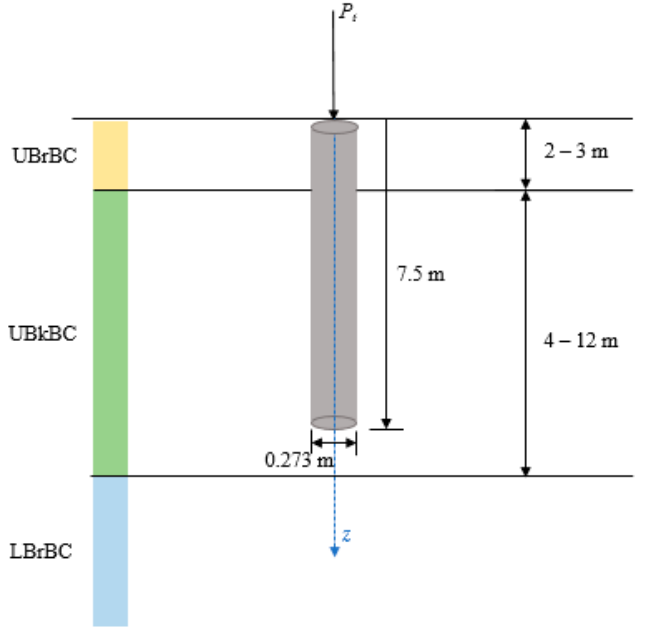
Figure 12. Pile Profile at TCD in Dublin.